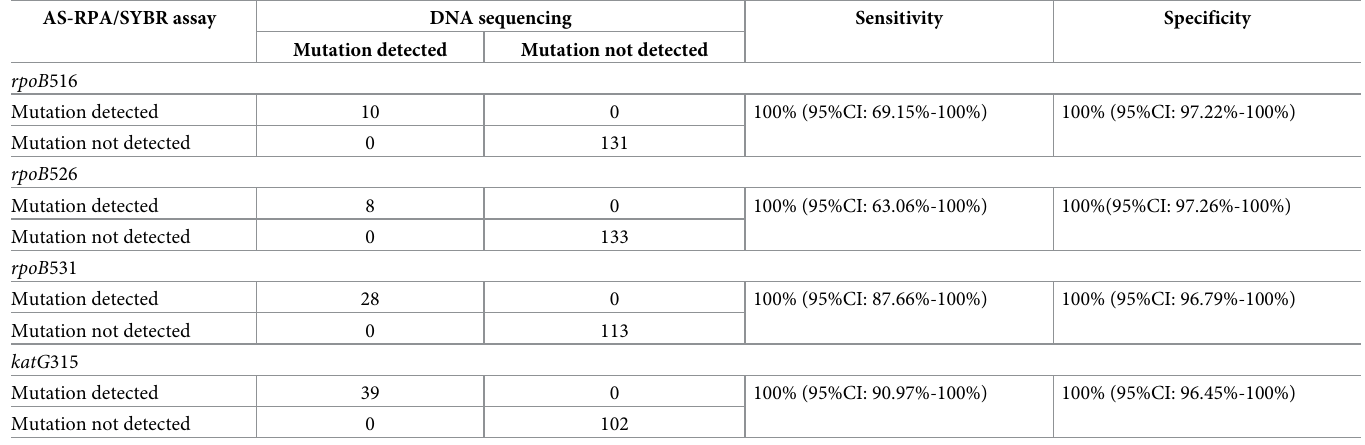
Table 6. Validation of AS-RPA/SYBR by a DNA sequencing analysis (N = 141). AS-RPA/SYBR